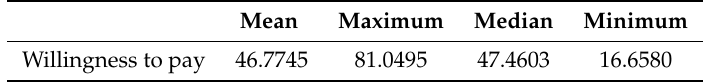
Table 4. Estimated willingness to pay for broiler produced by high welfare